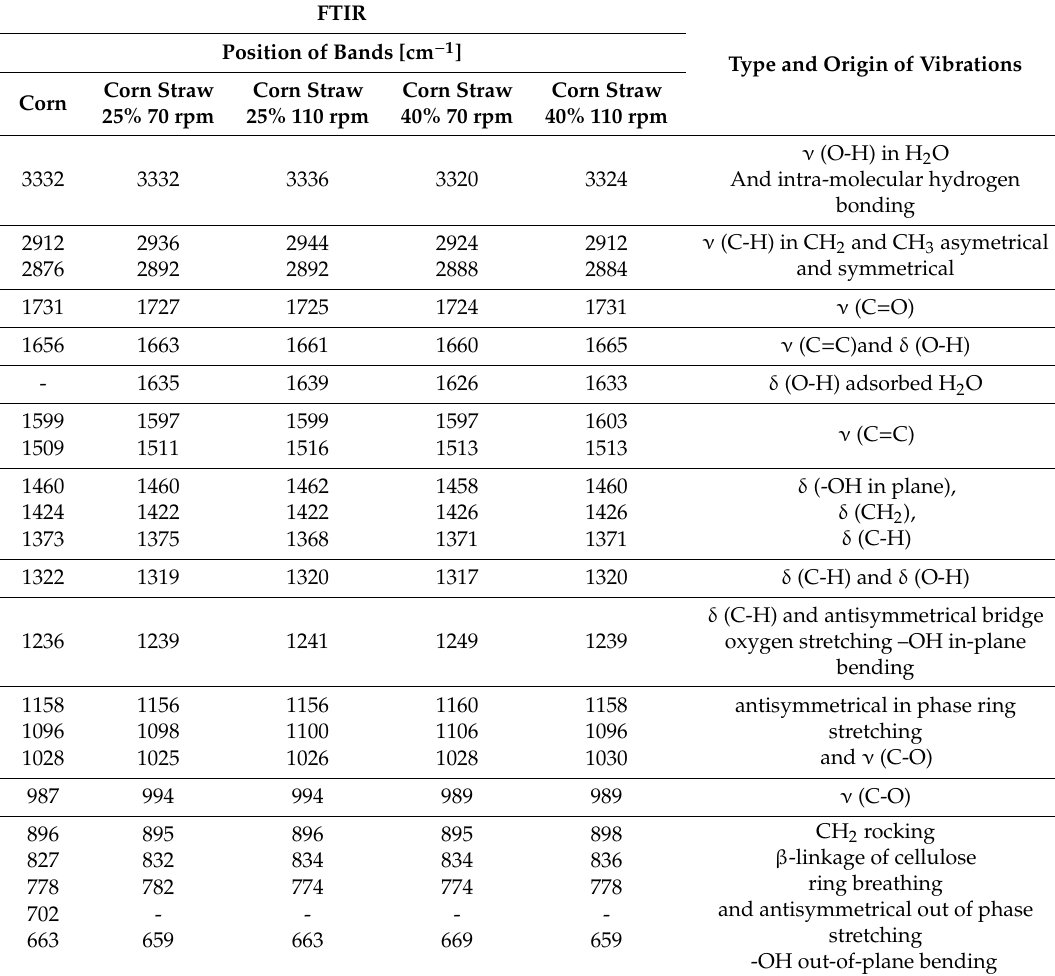
Table 2. The location of the maxima of FTIR absorption bands with the arrangement of appropriate vibration for selected samples of: corn, corn straw 25% and 70 rpm, 25% and 110 rpm and corn